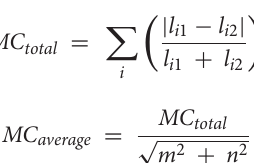
take into account contrast polarities in X-junctions when they judge surface characteristics (Kitaoka, 2005), and X-junctions are presumably important for solving the lightness–illumination ambiguity (e.g., Adelson, 2000), so the complication of this prior seems necessary for model